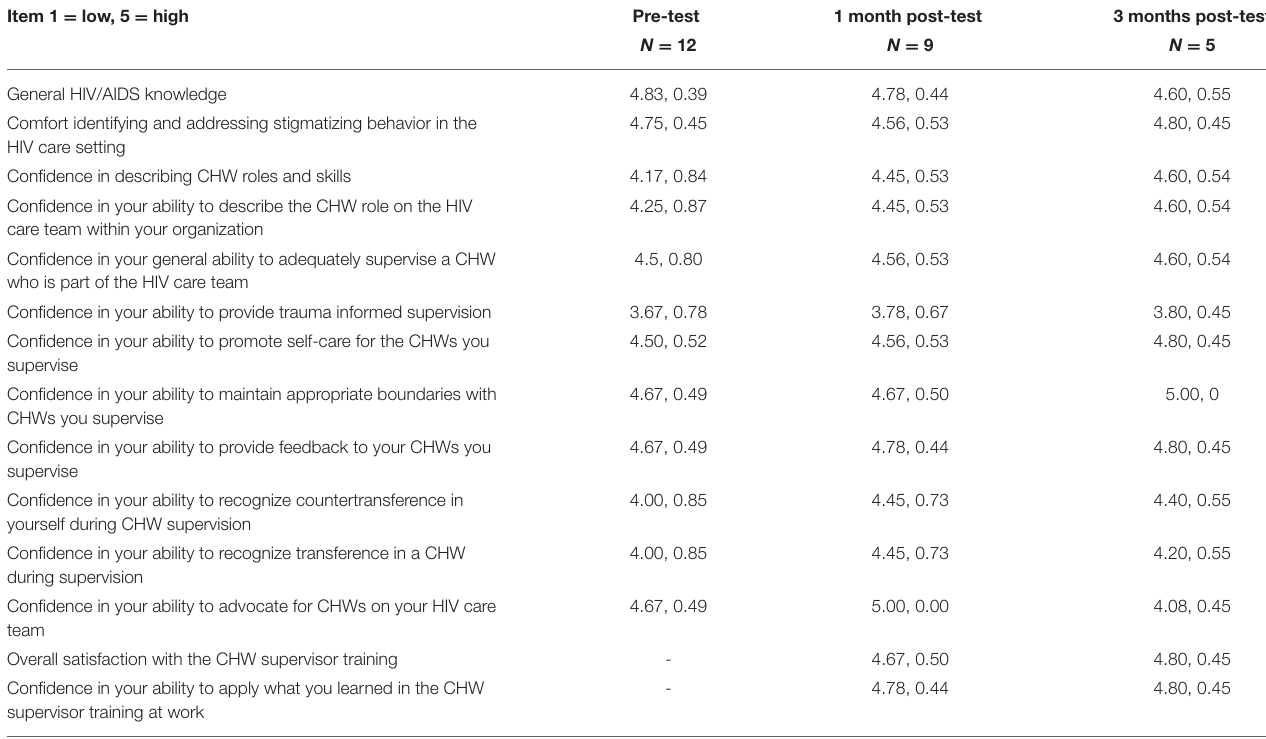
TABLE 4B | Changes in supervisor confidence from initial 16-hour training (mean, SD). Item 1 = low, 5 =